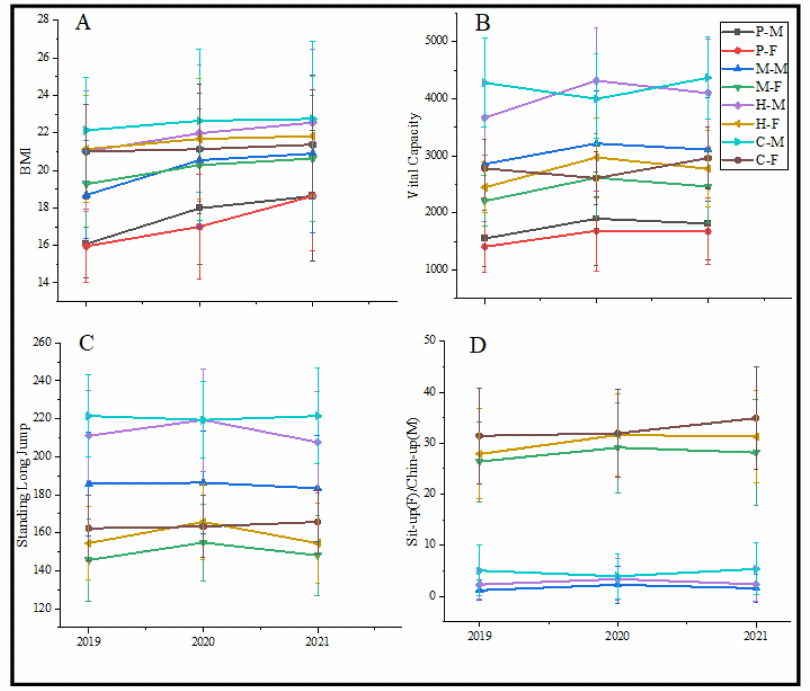
Figure 2. The trend of BMI, vital capacity, standing long jump, sit-up, and chin-up. ( A ) The trend of BMI; ( B ) The trend of vital capacity; ( C ) The trend of standing long jump; ( D ) The trend of sit up and chin up. P: Primary school; M: Middle school; H: High school; C: College; M: Male; F: